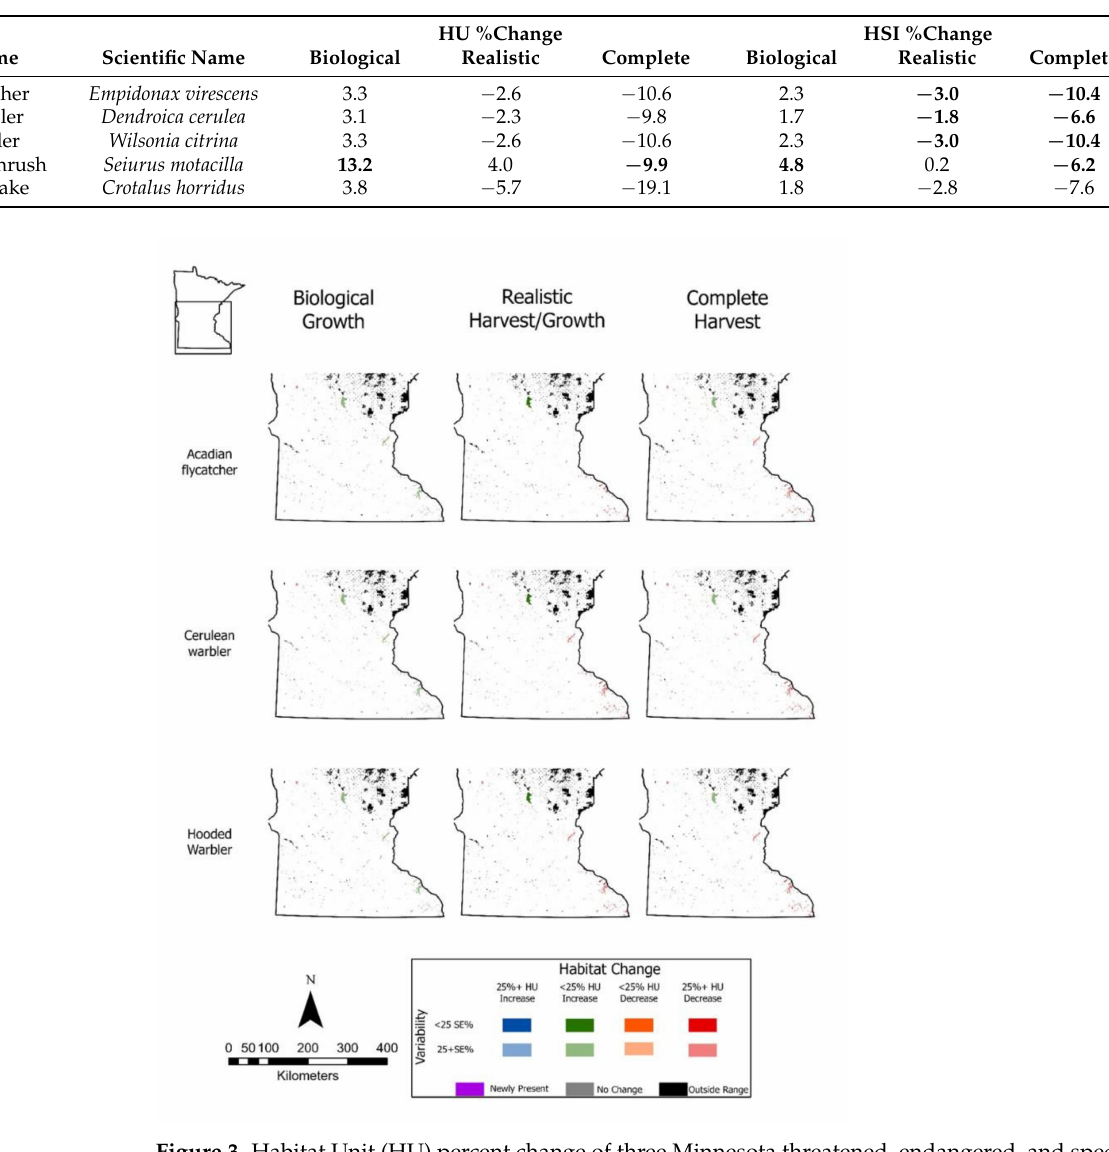
Figure 3. Habitat Unit (HU) percent change of three Minnesota threatened, endangered, and special concerns species under three simulated harvest/growth scenarios on Minnesota Department of Natural Resources lands. SE% refers to the standard error relative to the 2020 HU value. The timber rattlesnake habitat, concentrated in southeastern Minnesota, displayed mild and nonsignificant HU and HSI changes (Table 2). These changes followed a trend of increases under the biological growth scenario to decreases in the realistic growth/harvest and complete harvest scenarios (Figure